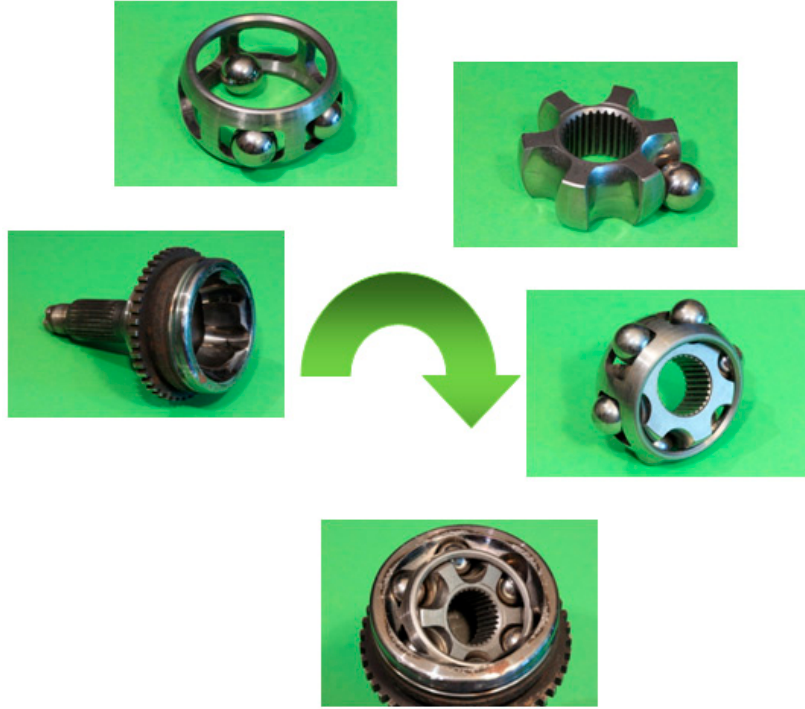
Figure 3. A Rzeppa homokinetic joint assembly.